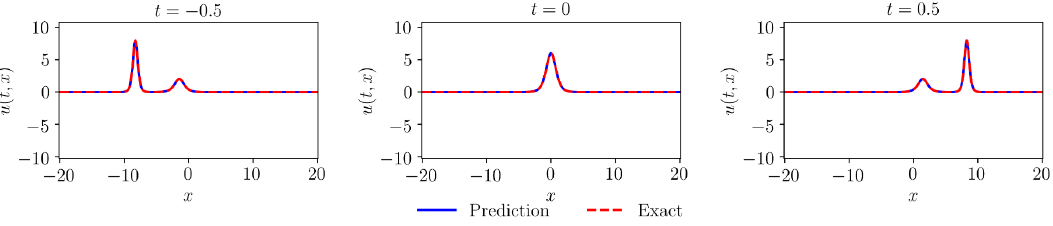
Figure 8. Comparison of the prediction given by physics-informed neural networks with the exact